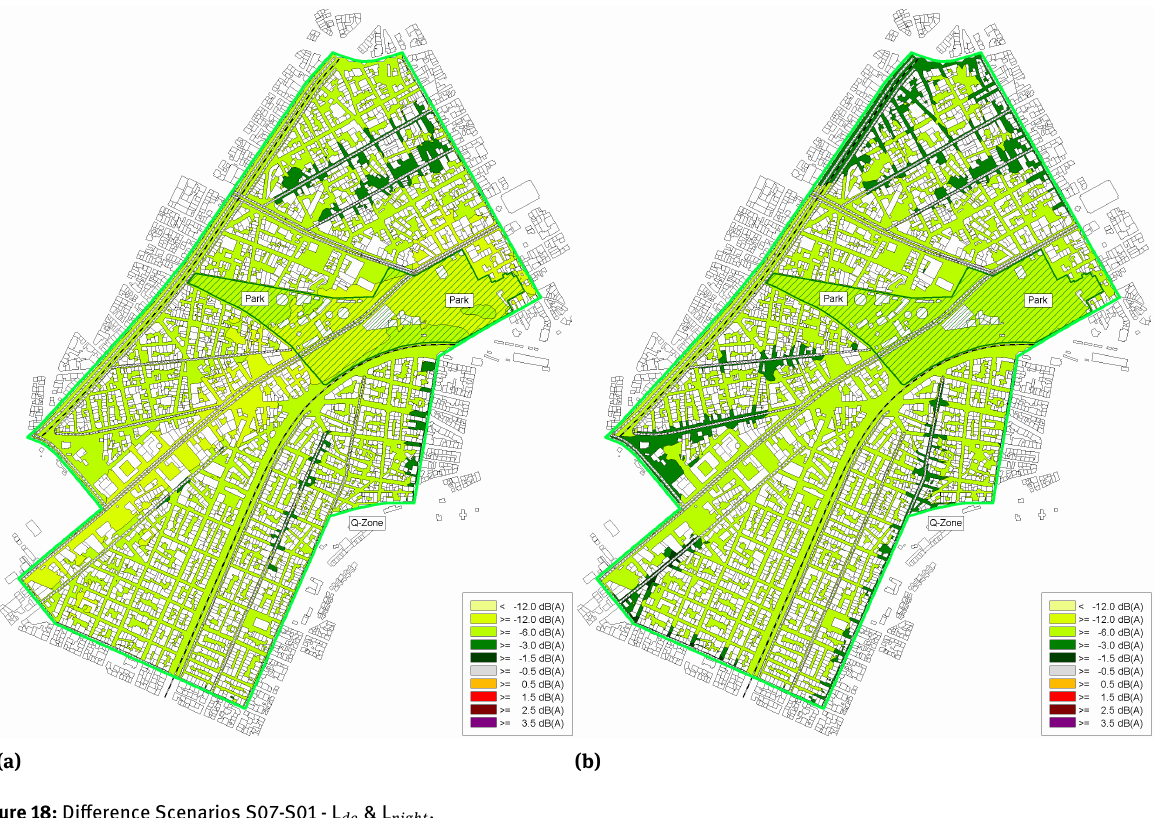
Figure 18: Difference Scenarios S07-S01 - L de & L night . Table 4: Q-Zone L de , av average values for each of the scenarios, the number of residents and the number of HAP in the Q-Zone.